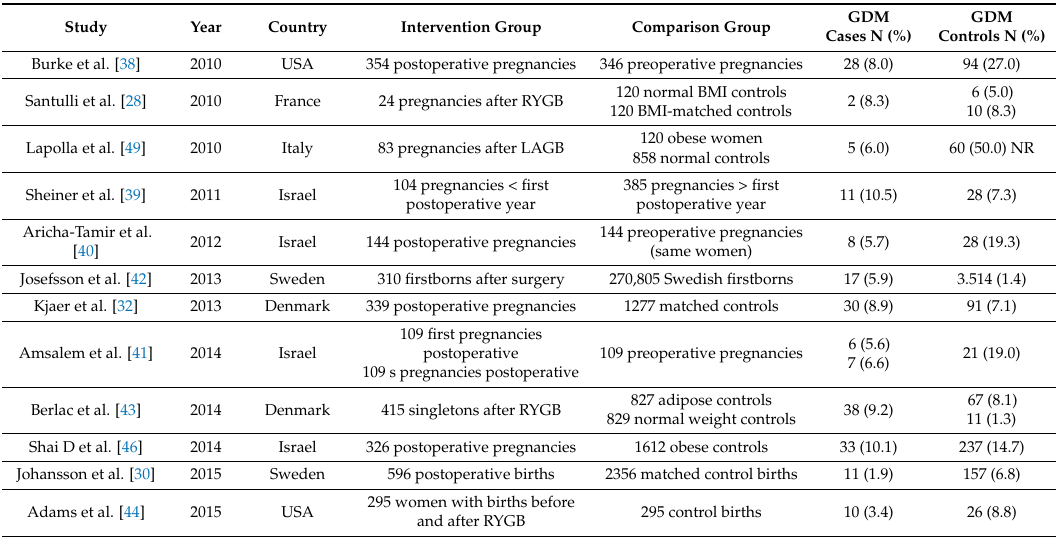
Table 1. Overview of studies evaluating the risk for GDM after bariatric surgery since 2010. Study Year Country Intervention Group Comparison